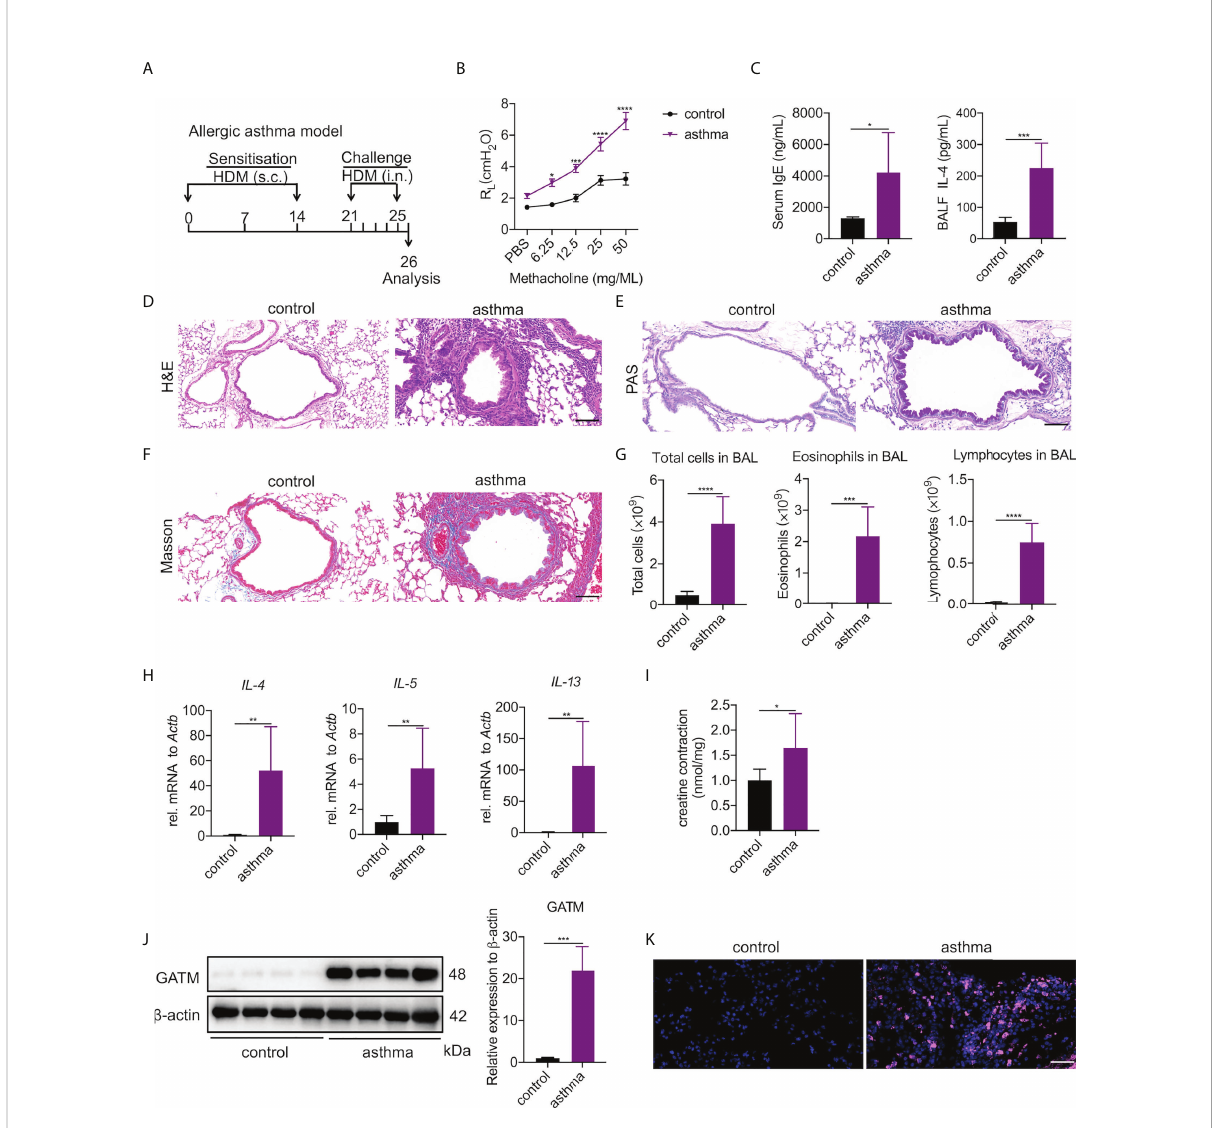
FIGURE 4 Pulmonary expression of GATM and creatine in HDM-induced asthma model. (A) Experimental timeline. (B) AHR as measured by lung resistance (R L ; n=7). (C) Serum level of IgE and BALF levels of IL-4 (n=6 – 8). (D) Representative H&E-stained lung sections showing different groups. Original magni fi cation x 200 (n=6). Scale bar=100 uM. (E) Representative PAS-stained lung sections showing goblet cell metaplasia in different groups. Original magni fi cation x 200 (n=4). Scale bar=100 uM. (F) Representative Masson-stained lung sections showing submucosal collagen deposition in different groups. Original magni fi cation x 200 (n=4). Scale bar=100 uM. (G) Total cells, eosinophils and lymphocytes in BALF